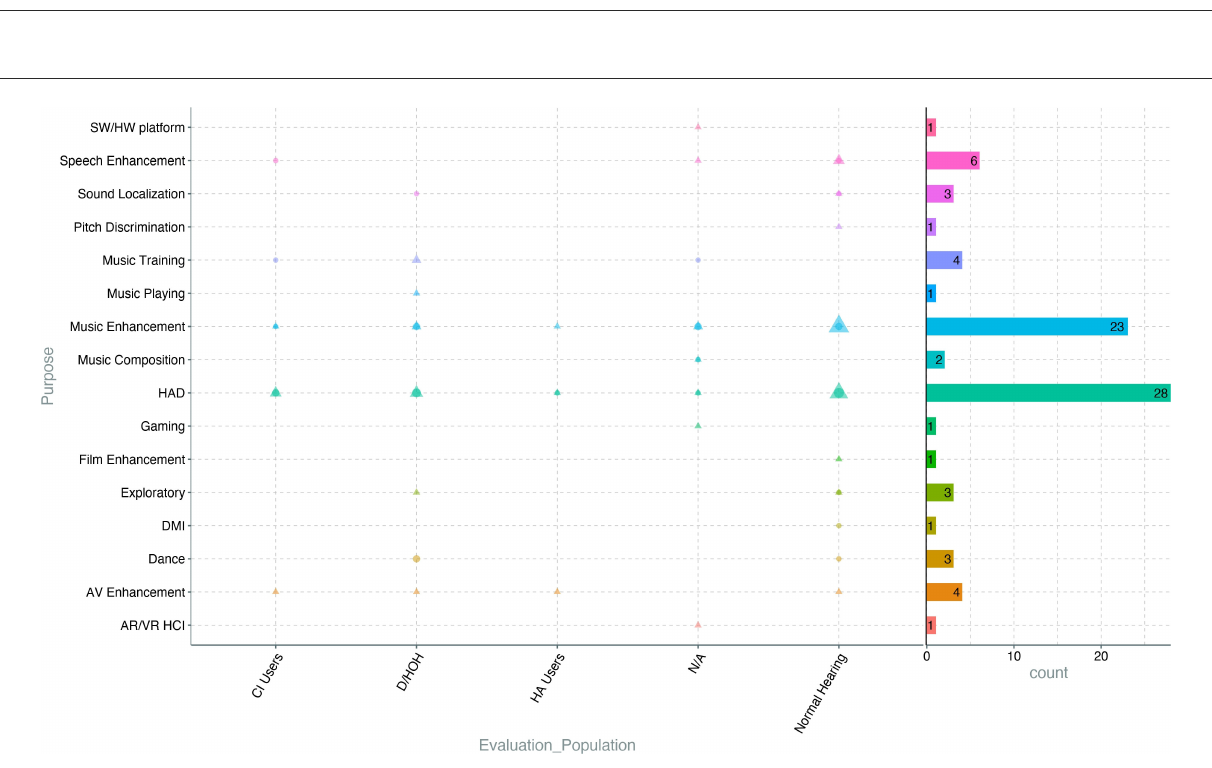
FIGURE10 Distribution of the purpose for each evaluation population; a triangle indicate a wearable device, a circle indicates a fixed device and the size of the shape represents the amount of similar devices. D/HOH represents persons suffering from a hearing disability, but without any hearing assistive device; items on Y axis are not